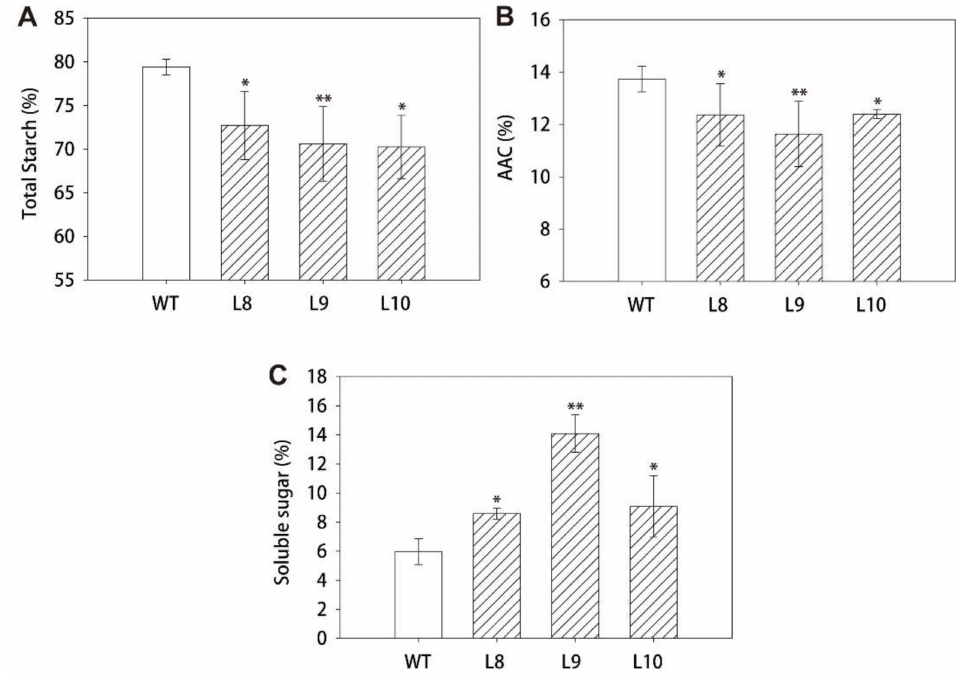
Figure 5. Overexpression of ZmES22 in rice altered the starch composition. ( A ) Total starch content in rice endosperm. ( B ) Apparent amylose content (AAC) in rice endosperm. ( C ) Soluble sugar content in rice endosperm. Data are presented as mean ± SD of three replicates. L: transgenic lines of ZmES22 seeds; WT: wild-type plants (Zhonghua 11), Student’s t -test, * p -value < 0.05, ** p -value < 0.01.